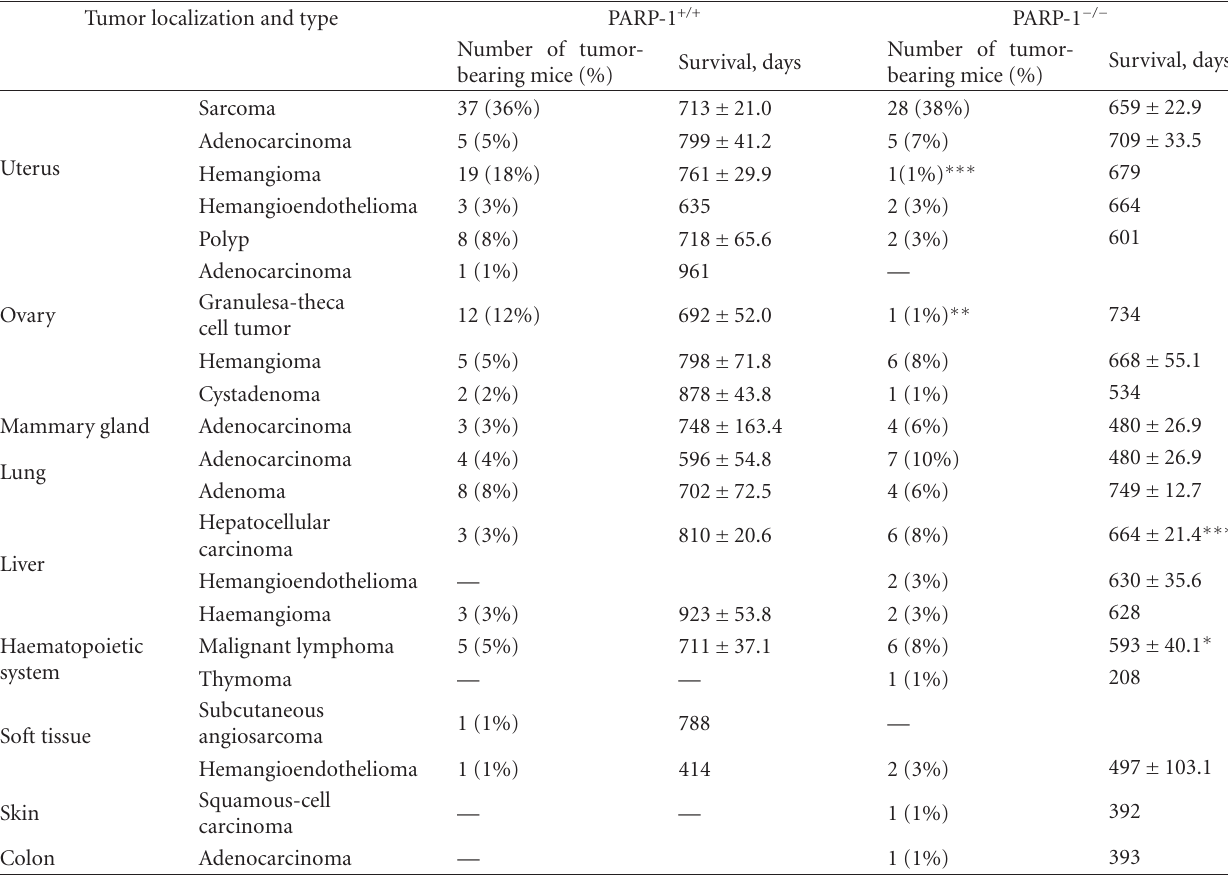
Table 4: Tumor site and type in PARP-1 − / − and PARP-1 + / + mice.